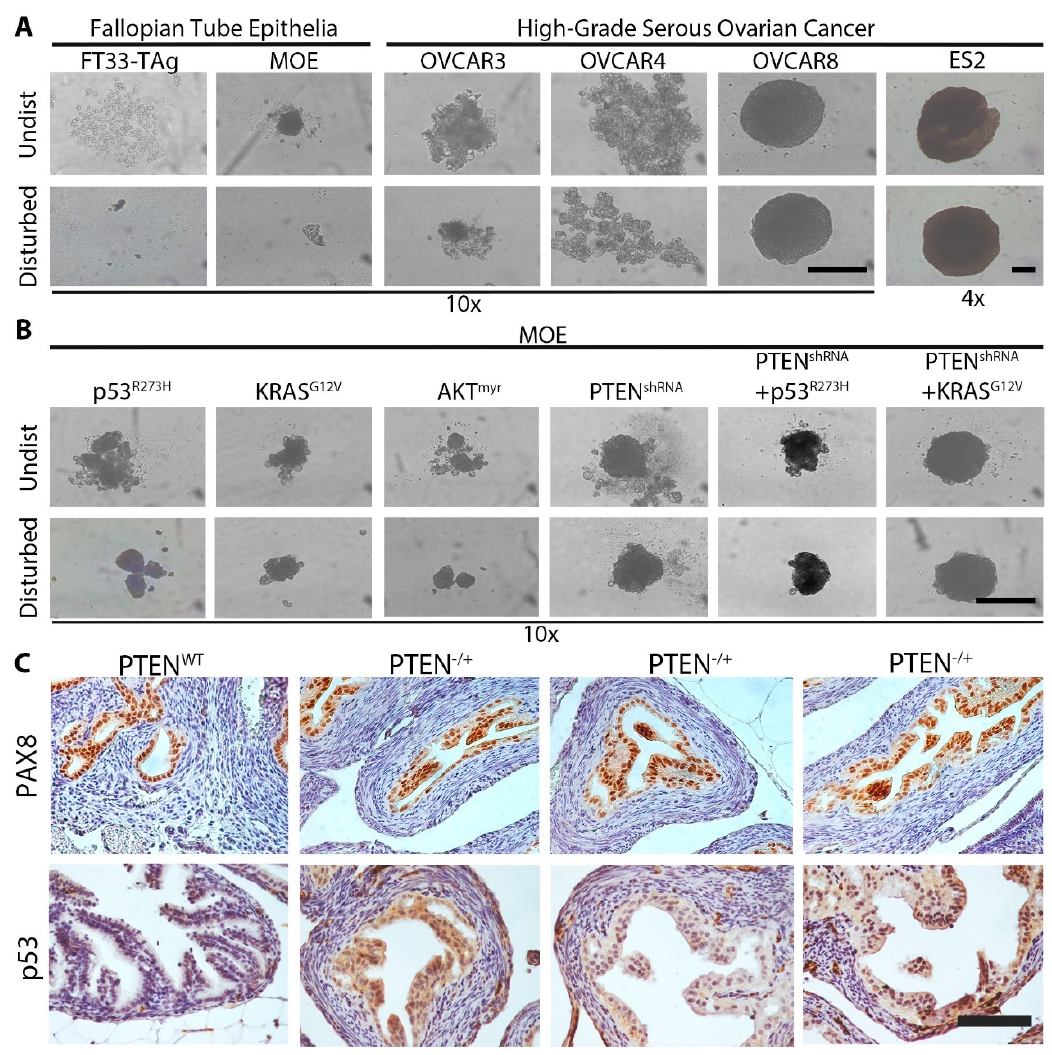
Figure 1. Loss of PTEN induces multi-cellular tumor spheroid (MTS) formation in vitro and in vivo. ( A , B ) Representative images of structures formed at seven days of culture in ultra-low adhesion (ULA) plates. Images were taken from undisturbed cells (undist) or after pipetting the contents of each well up and down (disturbed). Scale bar = 250 μ m. ( C ) Immunohistochemistry for PAX8 and p53 in the fallopian tubes of PAX Cre/+ PTEN +/+ (PTEN WT ) or PAX8 Cre/+ PTEN flox/+ (PTEN − /+ ) mice. Scale bar = 100 μ m. n = 4–6. Legend: MOE, murine oviductal epithelial.